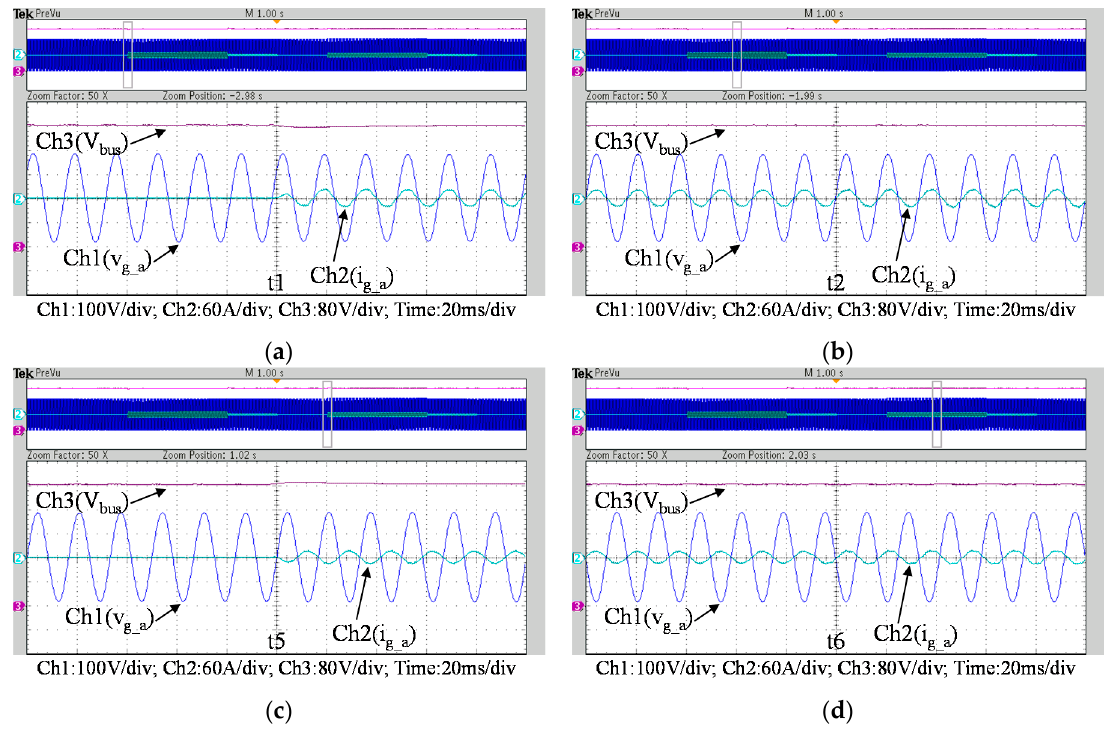
Figure 36. Detailed view of Figure 35a: ( a ) near t1; ( b ) near t2; ( c ) near t5; ( d ) near t6.